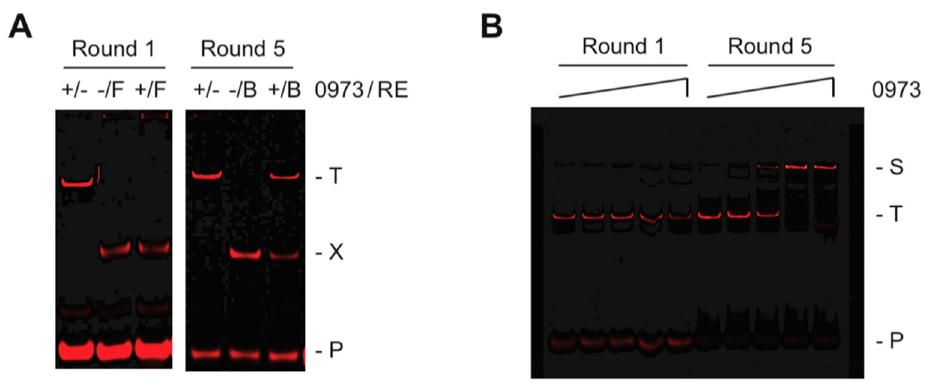
Figure 1. Selection and validation of TTHA0973-binding DNA sequences. ( A ) Shown are IR fluorescence images of restriction endonuclease cleavage protection assays made during Round 1 and Round 5 of REPSA selection with 17 nM TTHA0973 protein. The presence ( + ) or absence ( − ) of TTHA0973 and IISRE FokI (F) or BpmI (B) is indicated above each lane. The electrophoretic mobility of the intact (T) and cleaved (X) selection template, as well as the IRD7_ST2R primer (P), are indicated at the right of the figure. ( B ) Shown are IR fluorescence images of electrophoretic mobility shift assays made with DNA mixtures obtained following Round 1 (left lanes) and Round 5 (right lanes) of REPSA selection incubated with increasing concentrations of TTHA0973 protein (from left to right: 0, 0.8, 8, 80, or 800 nM TTHA0973). The electrophoretic mobility of a single protein-DNA complex (S) as well as uncomplexed ST2R24 selection template (T) and IRD7_ST2R primer (P) are indicated at the right of the